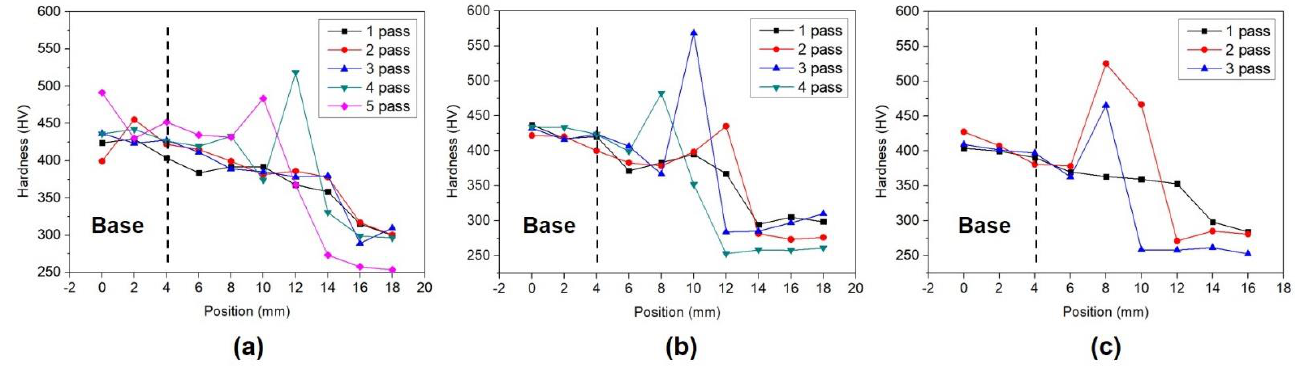
Figure 10. Hardness analyses results of FCAW weld with CO 2 5% and 20% shielding gas and heat input: ( a ) 00L; ( b ) 00M; ( c ) 00H.